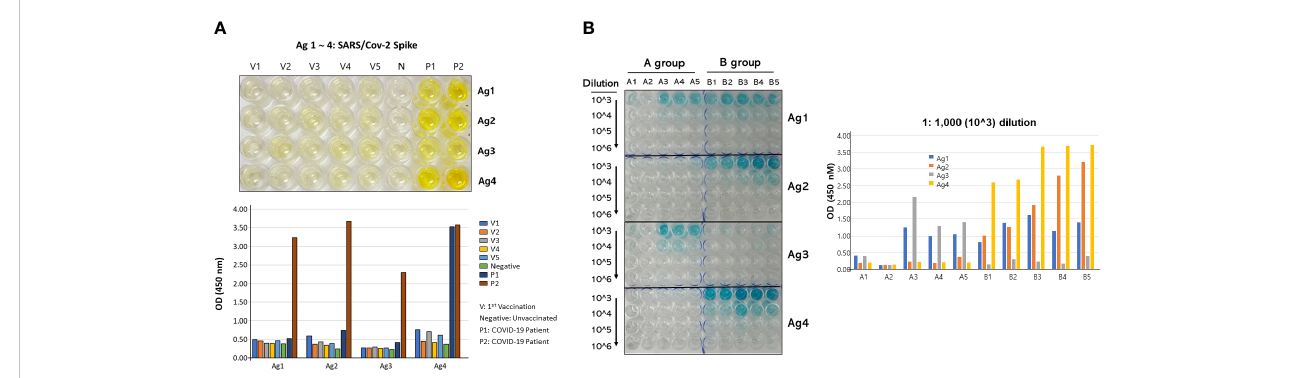
FIGURE 2 Antibody titers of serum against the four antigens. (A) ELISA plate showed the binding of the antigens with antibodies from sera of vaccinated (V1 ∼ V5), negative (N), and naturally infected patients (P1/2) (upper panel), and their numerical OD 450 values (lower panel). The patient 1 and 2 COVID-19 neutralizing indexes were 20 and 640, respectively. (B) ELISA plate showed the titration results of the antigens with antibodies formed in the two vaccinated mice groups (left) and their numerical OD 450 values (right). The antibody titration was performed by serial dilution from 1:1,000 (10 3 ) to 1:1,000,000 (10 6 ). All vaccinated people included in this study were vaccinated by P fi zer mRNA